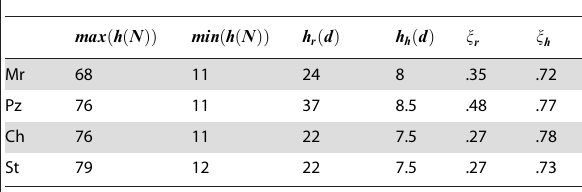
Table 2. The efficiency values.